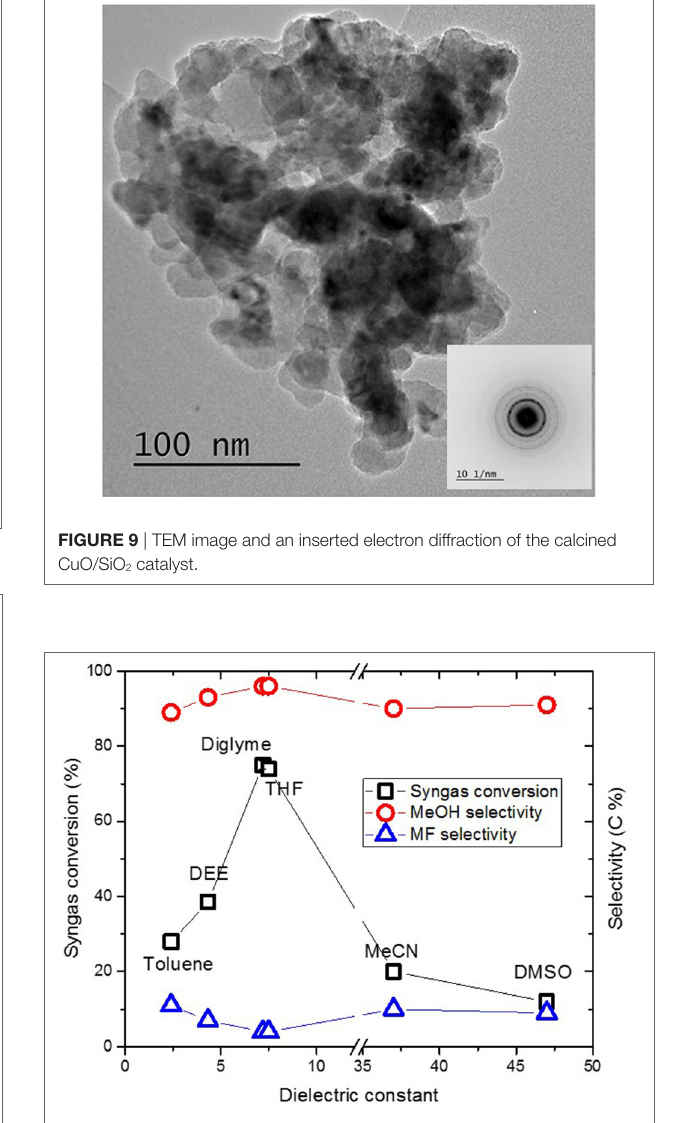
FigUre 10 | Syngas conversion and selectivity versus dielectric constant of solvent in the CuO/SiO 2 catalyzed